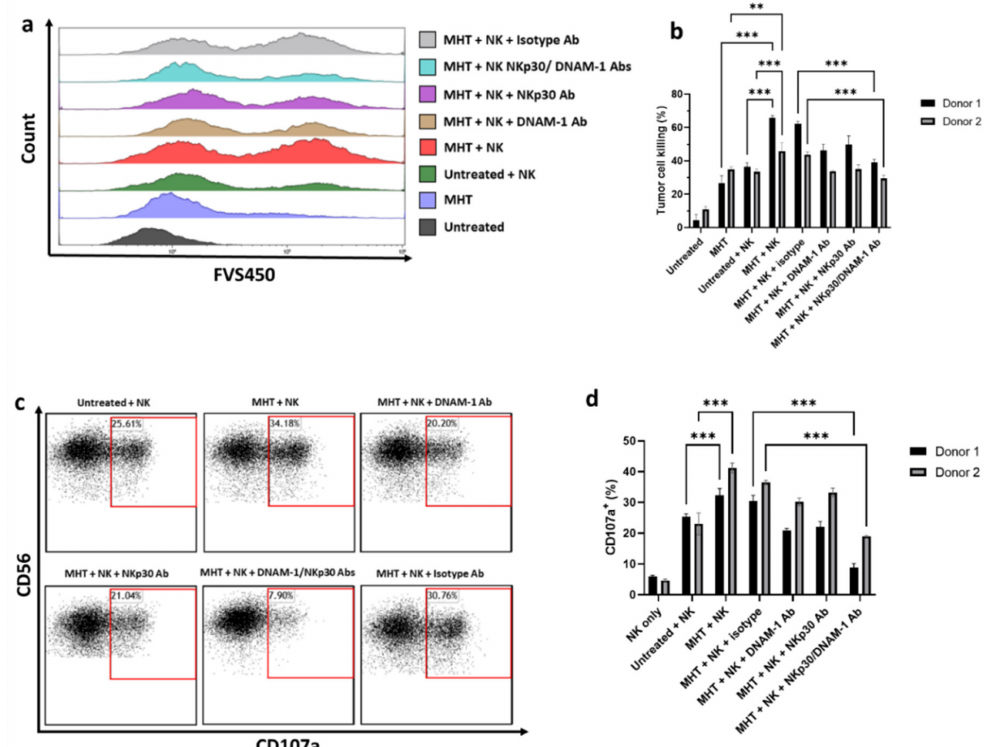
Figure 8. NK cell − mediated killing of U87 cells and degranulation activity. U87 cells were treated with MHT and co − cultured with IL − 2 − activated NK cells for 4 h at an E:T ratio of 1:1. Tumor cell killing of U87 cells was assessed via flow cytometry determining viability dye-positive (FSV450+) cells in U87 cells. ( a ) Data are shown as representative histograms ( a ) and mean ± SEM ( b ). IL − 2 − activated NK cells were co − incubated with U87 cells for 4 h at an E:T ratio of 1:1 in the presence of anti − CD107a antibody. The percentage of degranulating CD107a + /CD56 + NK cells was represented as individual plots ( c ) and mean ± SEM ( d ). Results shown are representative of three experiments using NK cells from two healthy donors. Statistical analysis was performed using a one − way ANOVA test (** 0.001 < p < 0.01; *** p < 0.001; n.s. = not